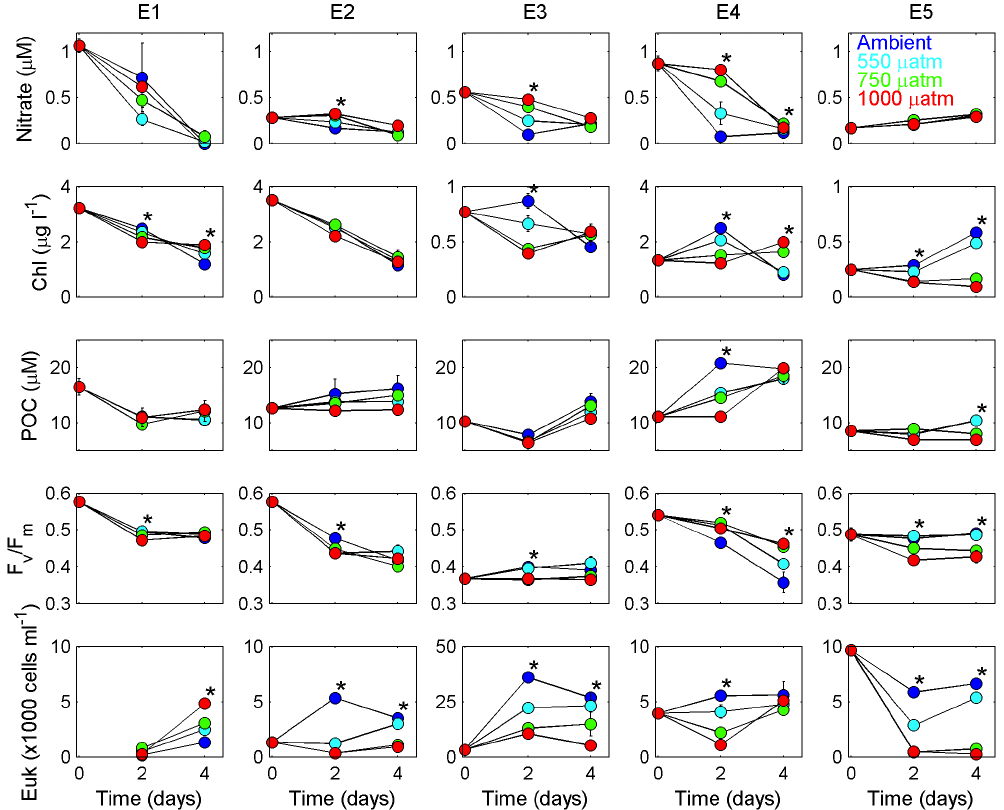
Figure 7. Time series measurements of nitrate (µmolL − 1 ) , total Chl a (µgL − 1 ) , particulate organic carbon (POC) (µmolL − 1 ) , photosyn- thetic efficiency ( F v /F m , FRRf) and pico- and nanoeukaryote counts (cell × 1000mL − 1 ) from the main experiments (E1–E5). Plotted values are means ± 1SE, for biological triplicates. Where error bars are not visible, these are smaller than the symbol size. Note differences in scales for chlorophyll and cell count measurements. Observation of any statistically significant differences between treatments (one-way ANOVA, p < 0.05) for each variable and time point are indicated by “*”. The detailed results of subsequent Tukey-Kramer means comparison tests are omitted for